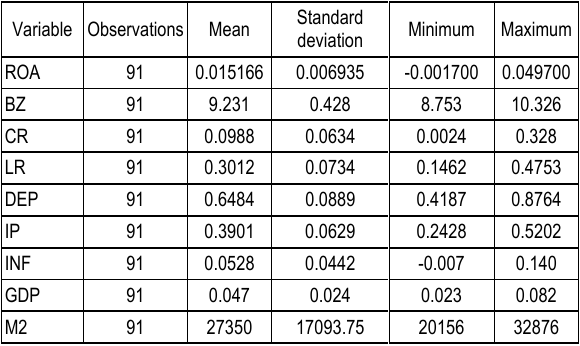
Table 4. The descriptive statistics for the